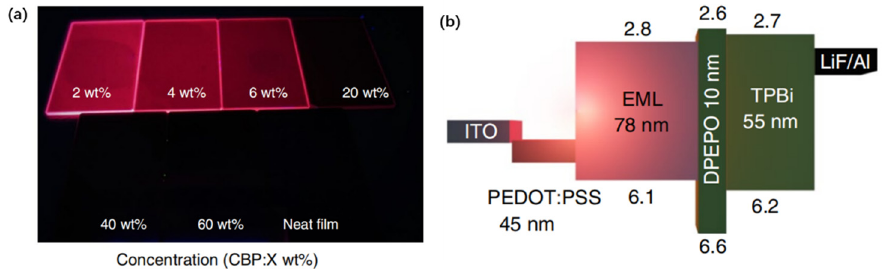
Figure 23. ( a ) Photographs under UV light (each sample: 1.5 × 2 cm 2 ) of M72 ; ( b ) Schematic representation and energy diagram of the NIR OLEDs (adapted from ref. [171]).